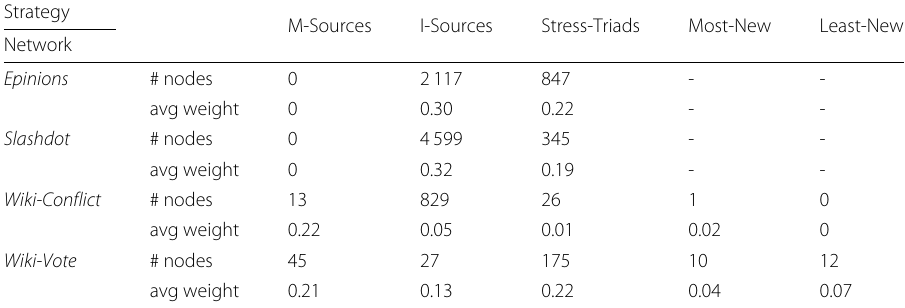
Table 3 Summary about negative influence spread ( k = 50) Strategy M-Sources I-Sources Stress-Triads Most-New Least-New Network Epinions # nodes 0 2117 847 - - avg weight 0 0.30 0.22 - - Slashdot # nodes 0 4599 345 - - avg weight 0 0.32 0.19 - - Wiki-Conflict # nodes 13 829 26 1 0 avg weight 0.22 0.05 0.01 0.02 0 Wiki-Vote # nodes 45 27 175 10 12 avg weight 0.21 0.13 0.22 0.04